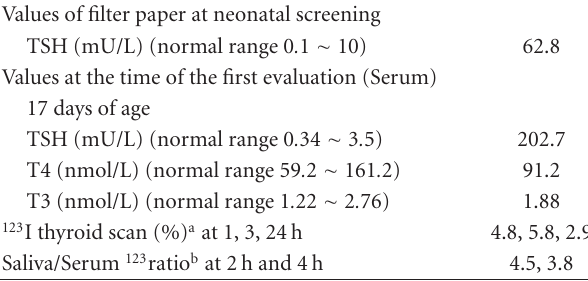
Table 1: Laboratory findings in the patient. Values of filter paper at neonatal screening